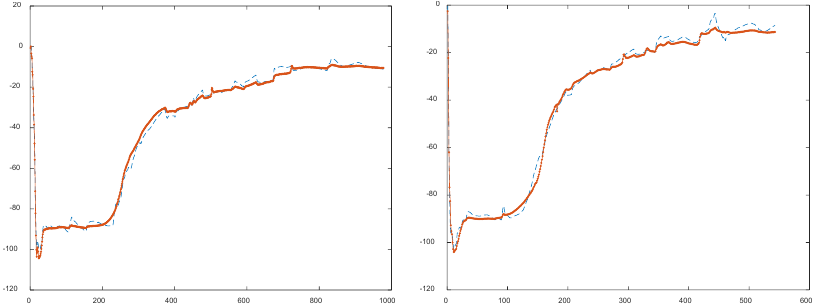
Figure 4. Outcome of the prediction − best ( left ) and worst ( right ) predictions for dehydration (Number of data on the x -axis, ∆ T on the y